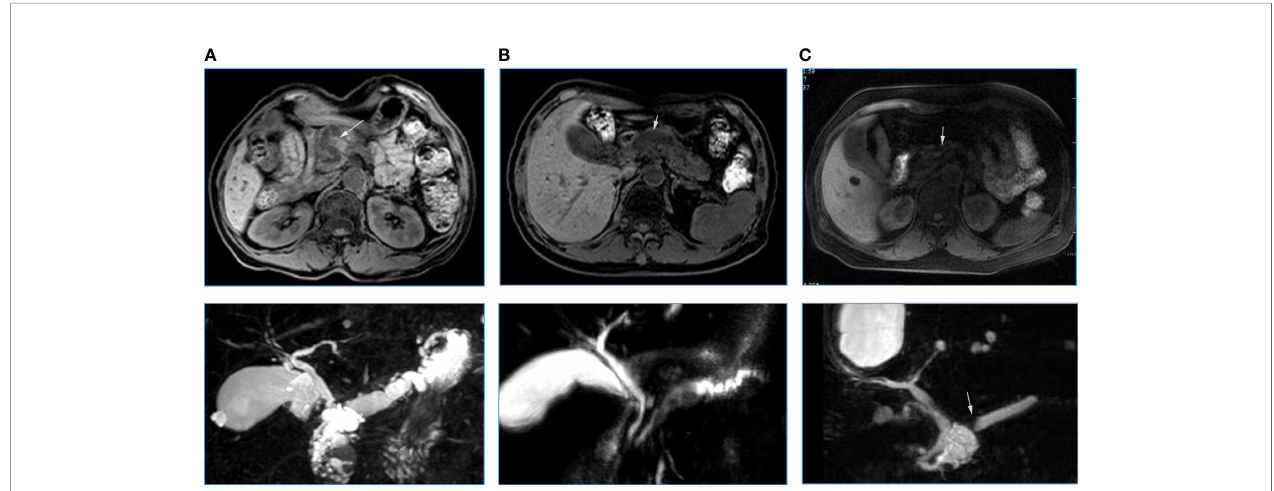
FIGURE 2 | Three cases of IPMNs with (A, B) or without (C) pancreatic atrophy. A: A 67-year-old woman with IPMN-derived invasive carcinoma in pancreatic head (white arrow). Atrophy occurred in the pancreatic body and tail. Pancreatic duct dilatation occurred (below). B: A 61-year old man with low-grade IPMN in the pancreatic head. Pancreatic duct dilatation occurred (white arrow), but pancreatic atrophy was not observed. C: A 57-year old woman with low – moderate grade of IPMN in pancreatic head. An abrupt change in the caliber of the main pancreatic duct (bottom white arrow) with body pancreatic atrophy was observed (the ratio between the main pancreatic duct diameter and the width of the total gland was 0.54, white arrow).